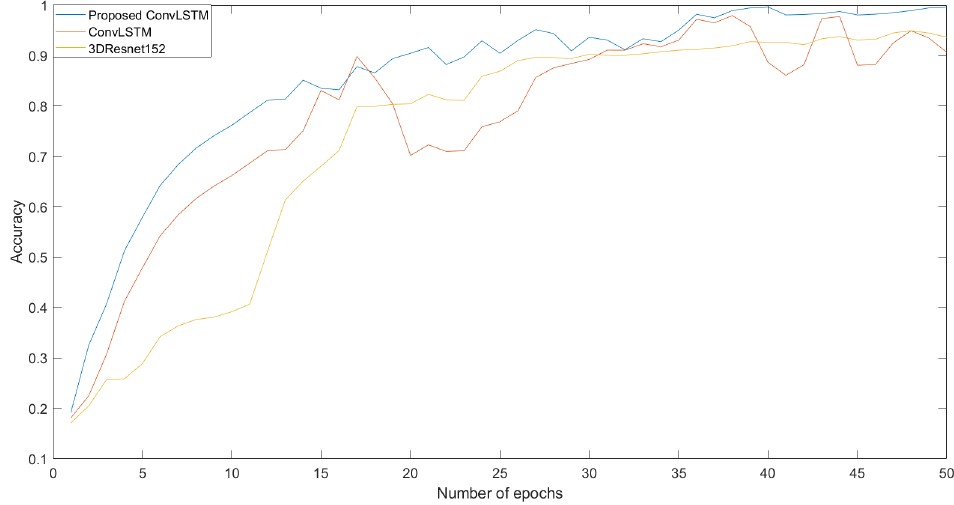
Figure 8. Comparison of accuracy during training process (ConvLSTM, 3D Resnet152, and proposed